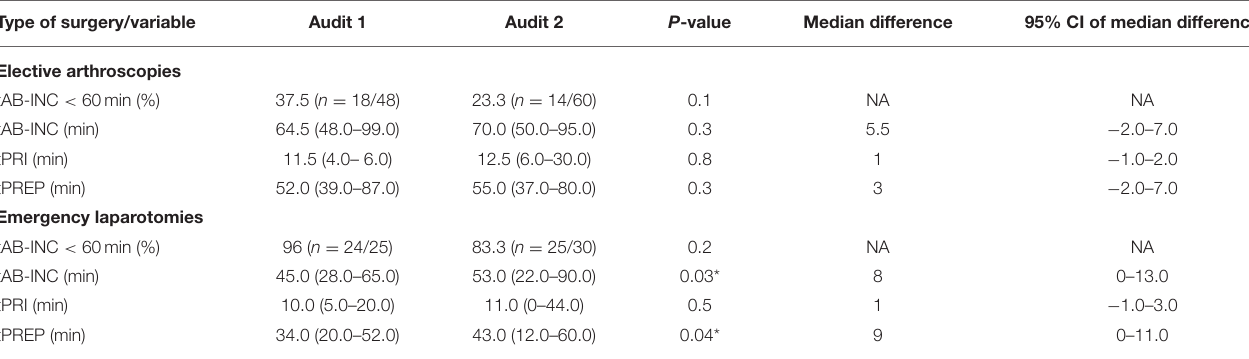
TABLE 2 | Percentage of surgeries with an antimicrobial dosing to incision time (tAB-INC) < 60min and times [median (range)] for time data. Type of